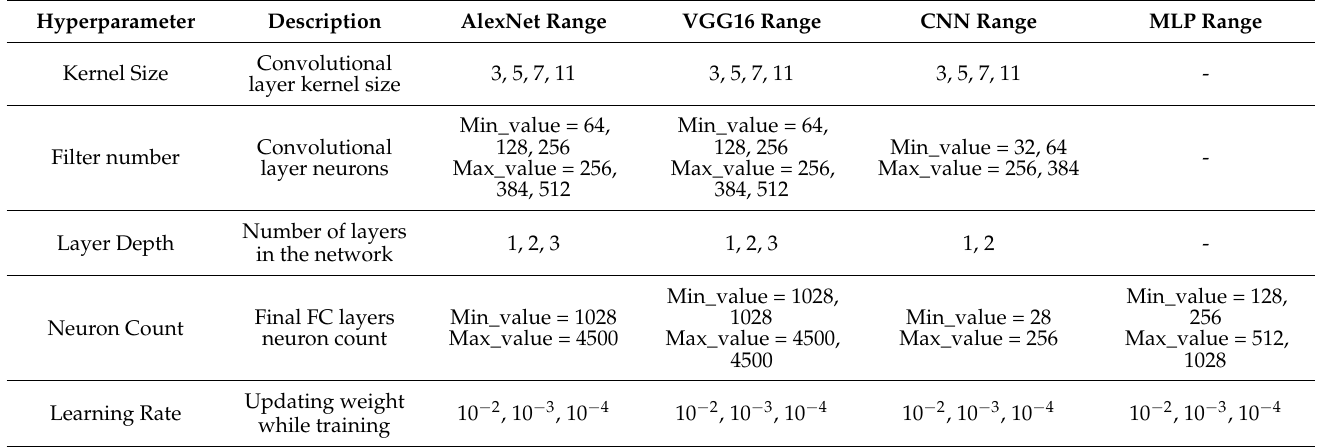
Table 1. Hyperparameters and their range for the four